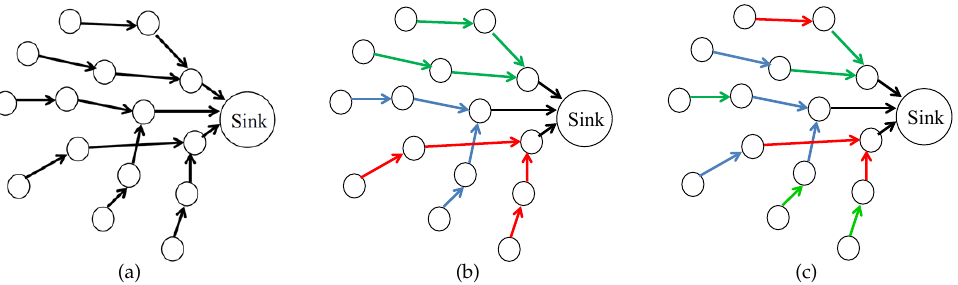
Figure 5. Illustration of the benefit of using multiple channels in reducing overhearing. ( a ) A typical single-channel tree based WSN is depicted, where each node experiences overhearing of transmissions from all nodes within its range. The goal of this work is to develop a multi-channel tree for such WSNs to extend its lifetime, as illustrated using multiple colors representing channels in ( b , c ). The channel assignment in ( b ) tries to maintain the same channel assignment in each path, whereas that in ( c ) has different channels on the same path, requiring frequent channel switching. Nodes in ( b , c ) have fewer neighbors on the same channel in comparison to that in ( a ), implying lower